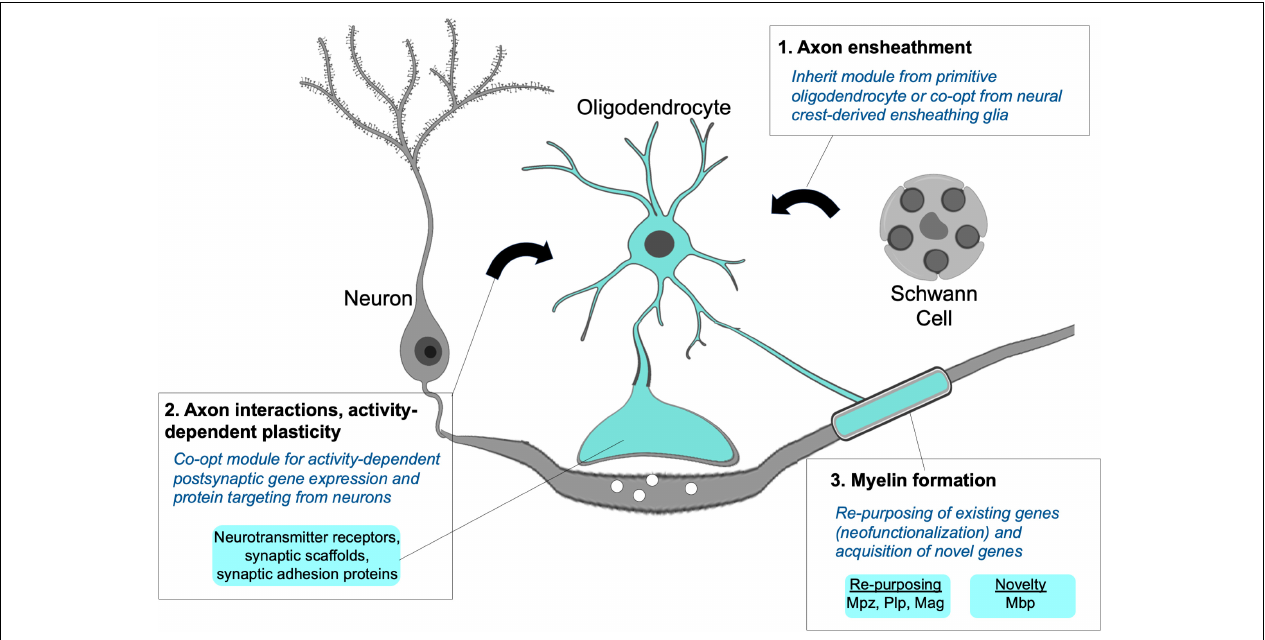
FIGURE 5 | Module integration responsible for the origins of the myelinating phenotype. A hypothetical model proposes the myelinating apomere integrating modules for axon ensheathment (1), activity-dependent axon interactions and structural remodeling (2), and formation of compact myelin sheaths (3). Primitive oligodendrocytes may not have possessed all modular components, but their novel and combined use for myelination can be explained through co-option from neurons and non-myelinating Schwann cells along with the recruitment and re-purposing of existing genes required to form myelin